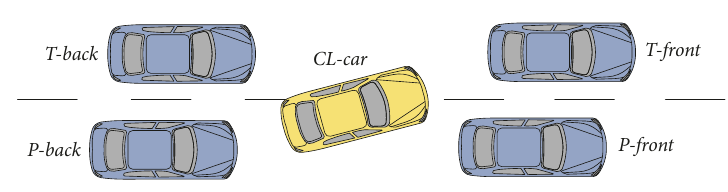
Figure 1: Vehicle